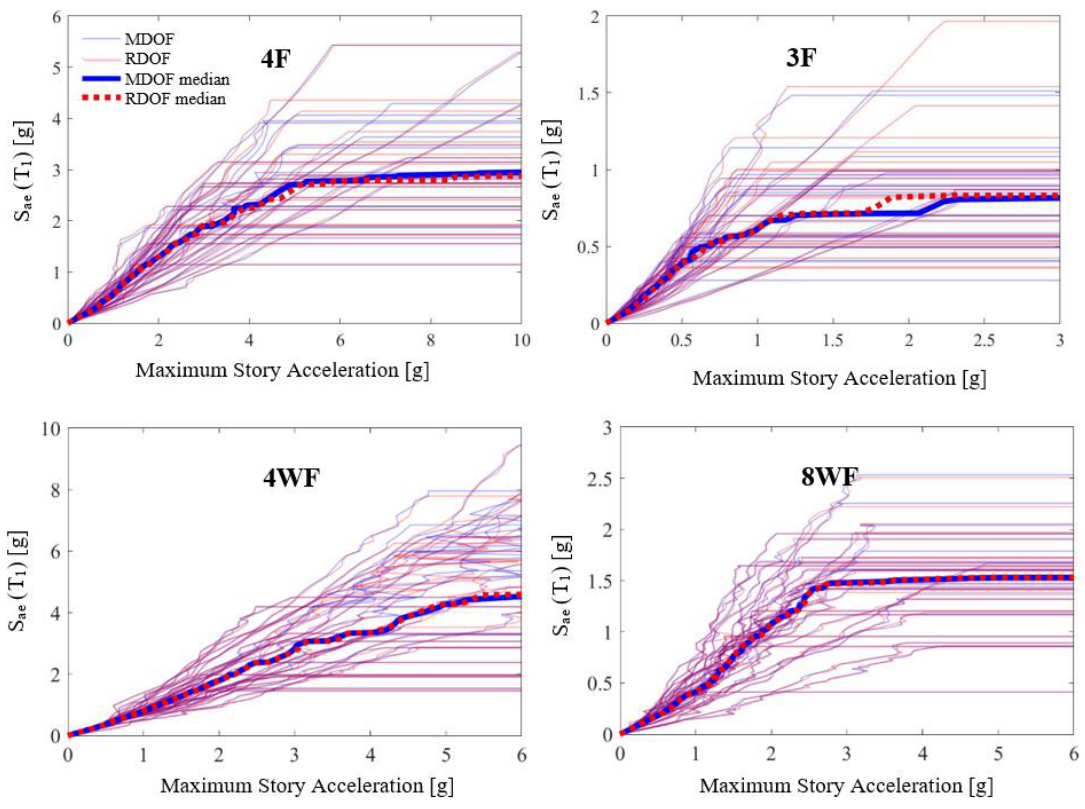
Figure 10. IDA curves in the format of spectral accelerations at the fundamental period of a building, S ae (T 1 ), versus maximum storey acceleration for the selected set of ground motions and the corresponding median for the RDOF and MDOF model of 4F, 3F, 4WF, and 8WF buildings.